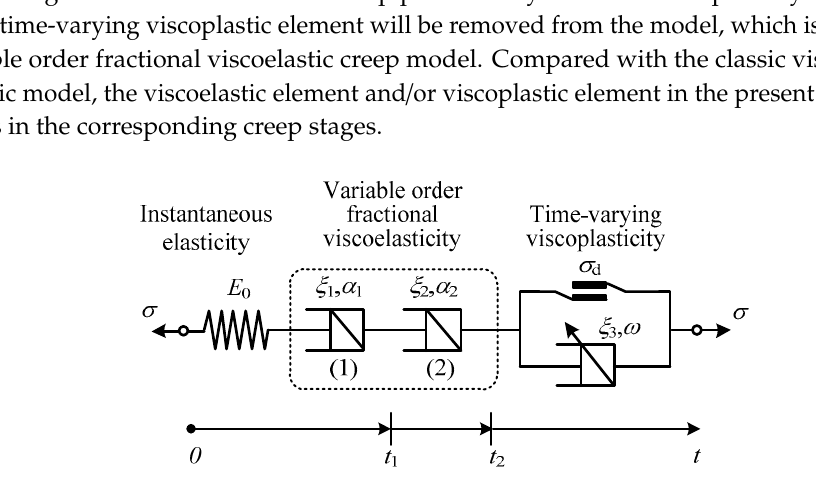
Figure 4. Fractional viscoelastoplastic creep model with variable order.